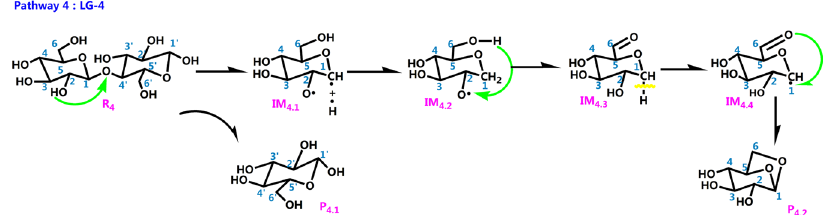
Figure 8. Pathway 4 reaction process.